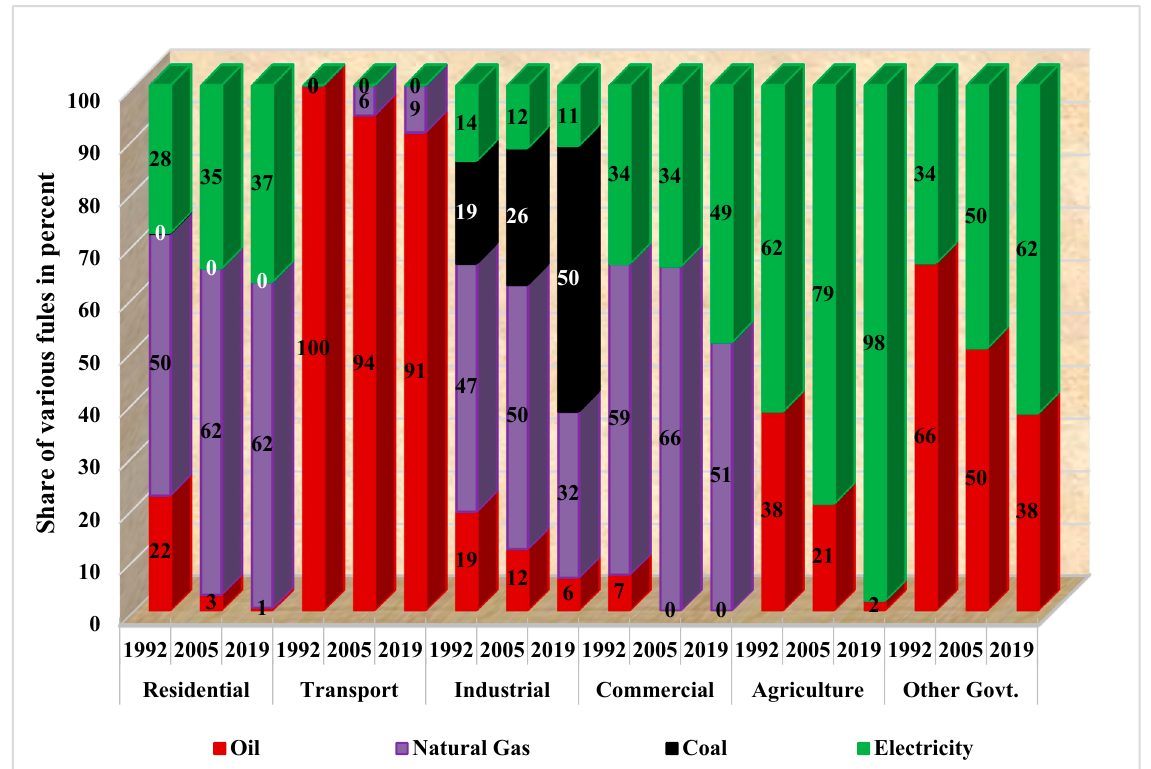
Figure 2. Energy fuels mix across various sectors in Pakistan .